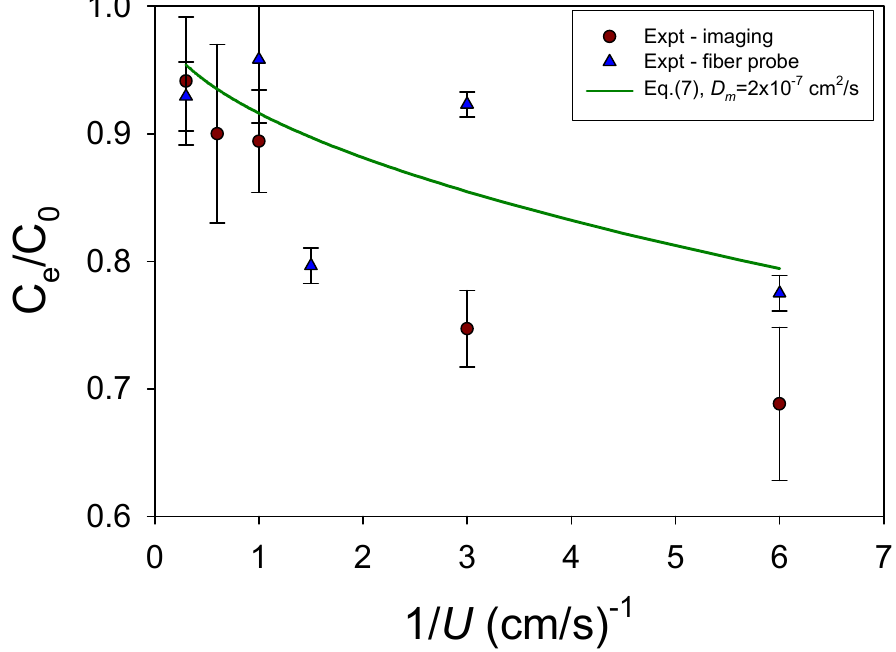
Fig. 5 (a). Comparison of experimental and analytical results for fibrinogen (C 0 = 100 nM) diffusivity in phosphate buffer (pH7.4, room temperature).